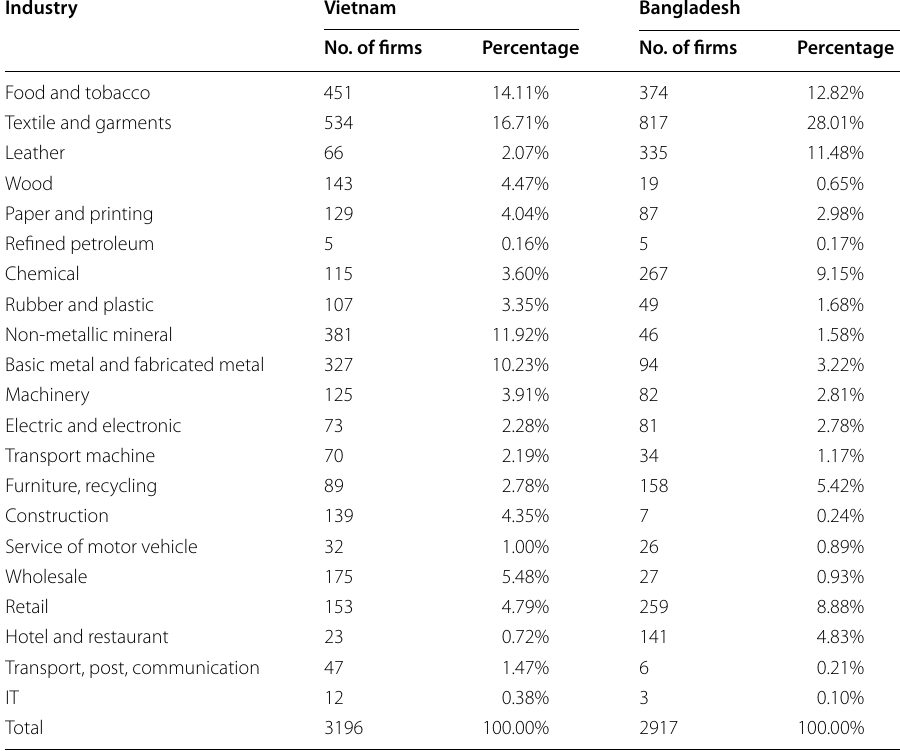
Table 4 Distribution of firms by industries Source: Author’s calculation based on the World Bank’s Enterprise Survey data (for Vietnam panel data of 2005, 2009, and 2015; for Bangladesh panel data of 2007, 2011, and